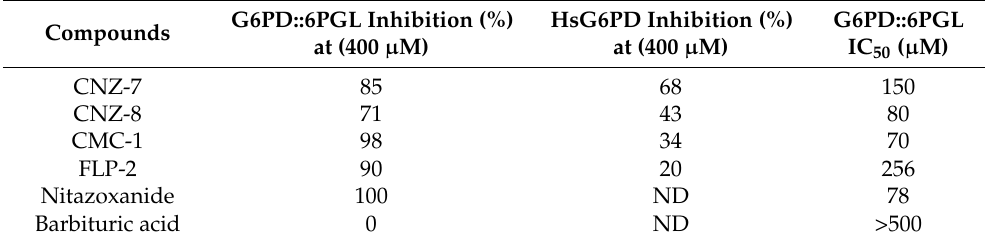
Table 1. The compounds from an in-house-library show inhibition of more than 70% on the